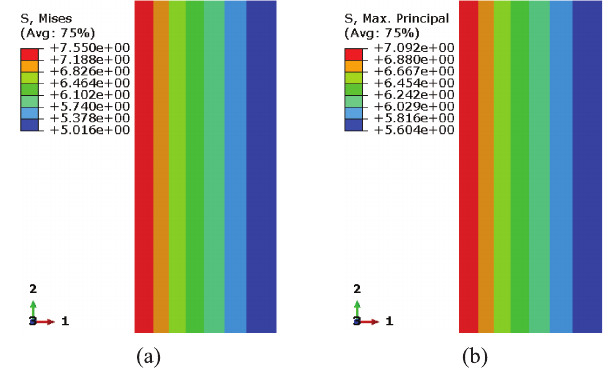
Fig. 7: The initial stress distribution of σ e and σ p at 950 °C (t =